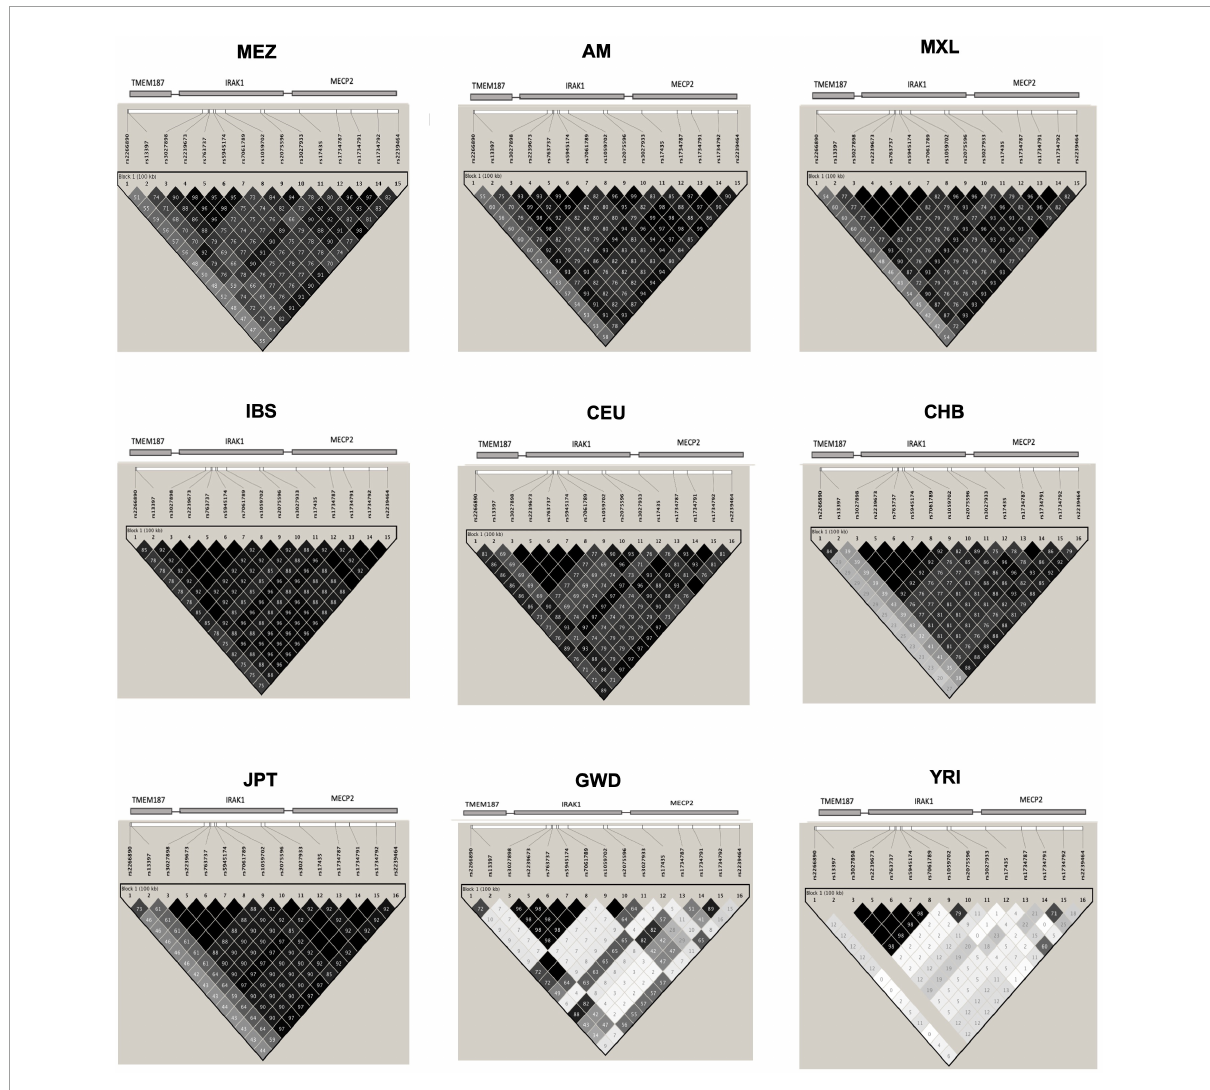
FIGURE1 Linkage disequilibrium (LD) plot of the single-nucleotide variants (SNVs) in the Xq28 region. MEZ, Mestizo from the present study; AM, Amerindians from the present study; MXL, Mexican Ancestry from Los Angeles USA from the 1KGP phase 3; IBS, Iberian population in Spain from the 1KGP phase 3; CEU, Utah Residents with Northern and Western European ancestry from the 1KGP phase 3; CHB, Han Chinese in Beijing, China from the 1KGP phase 3; JPT, Japanese in Tokyo, Japan from the 1KGP phase 3; GWD, Gambian in Western Division, The Gambia-Mandinka from the 1KGP phase 3; YRI, Yoruba in Ibadan, Nigeria from the 1KGP phase 3. The color scale (black = significance; white = no significance) highlights the pair-wise D’, and the numbers on the boxes represent the pair-wise r 2 between the SNVs that are marked on the top of the LD plot. The location of each SNV is indicated at the top of the LD